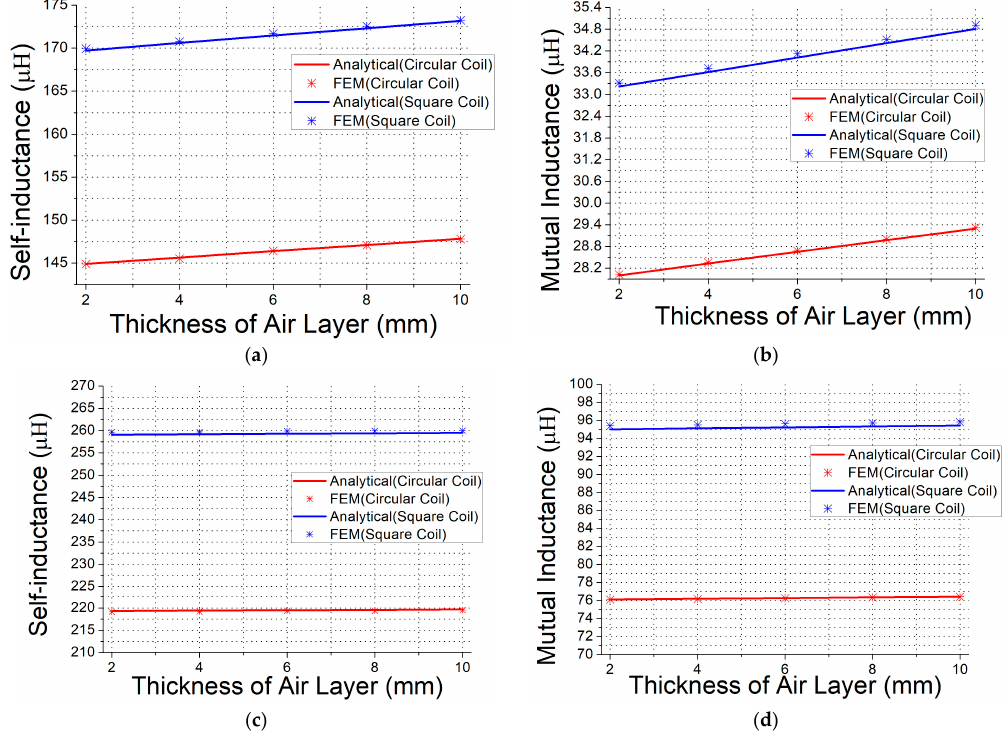
Figure 4. ( a ) Self-inductances with ferrite layer of µ r = 30. ( b ) Mutual inductance with ferrite layer of µ r = 30. ( c ) Self-inductances with ferrite layer of µ r = 150. ( d ) Mutual inductance with ferrite layer of µ r = 150.